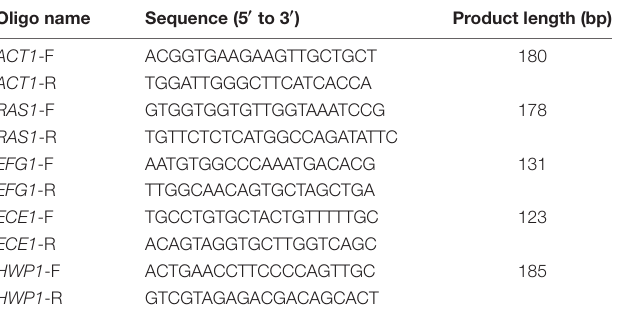
TABLE 1 | Primers used in this study.